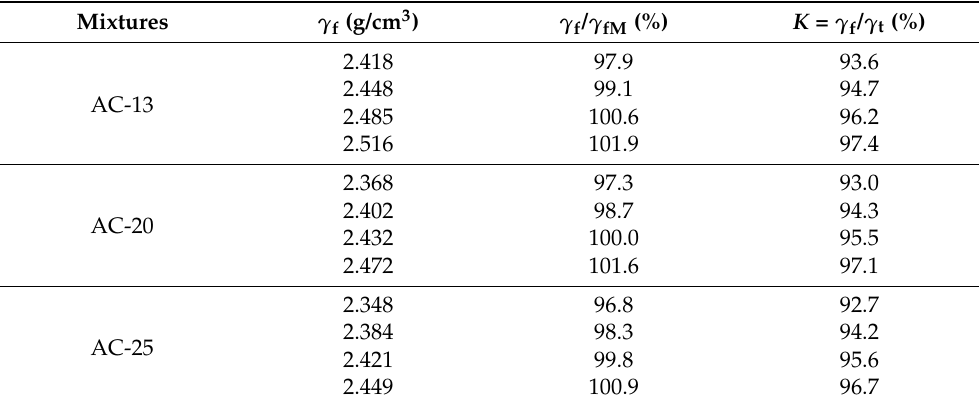
Table 6. Density and compactness results for the slab